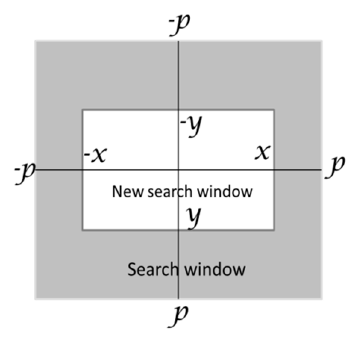
Figure 2. Default search window vs proposed search window. Algorithm 2. Finding the new search window.